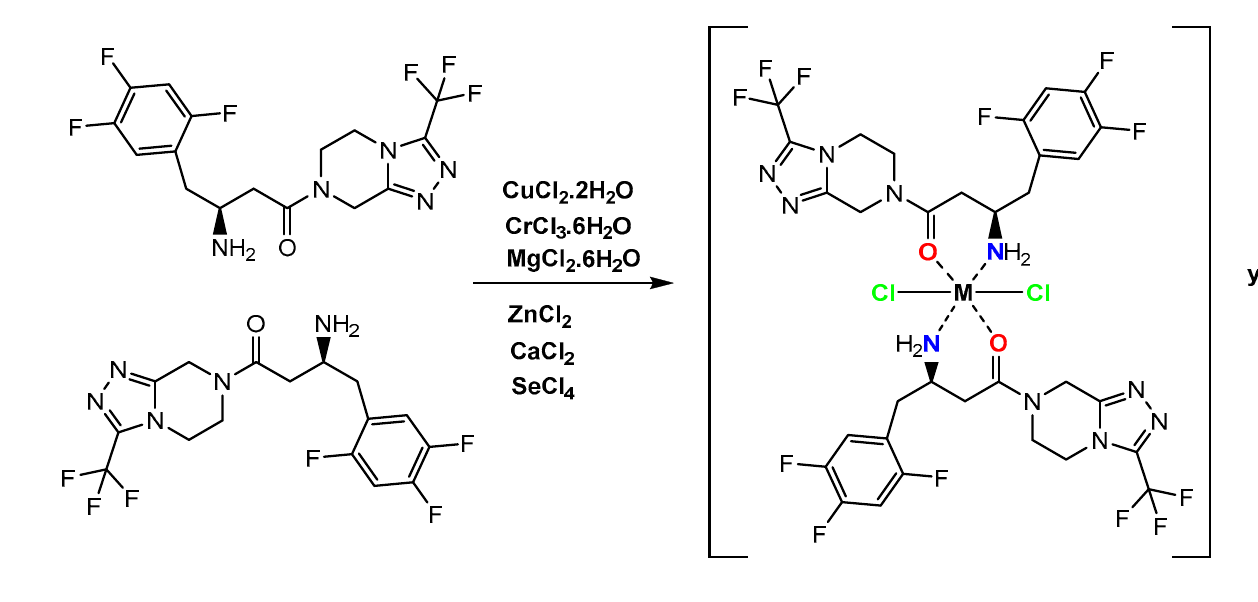
Figure 1. Suggested structures of STG complexes. Table 1. Analytical data of the STG complexes.